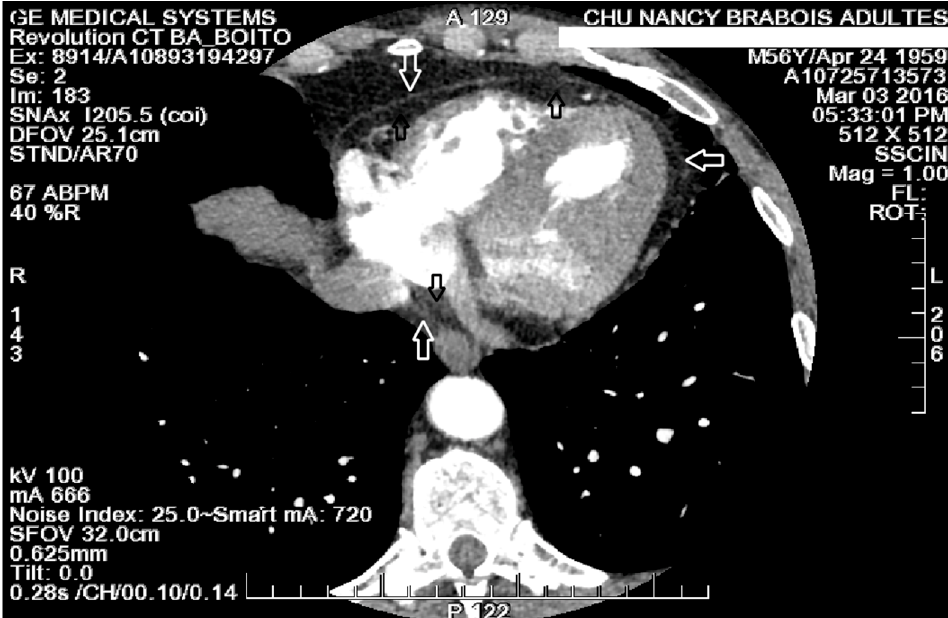
Figure 2. EAT measurement on a multiplanar reformatted CT image of the heart. Fibrous pericardium (white arrows) and epicardial fat (black arrows).